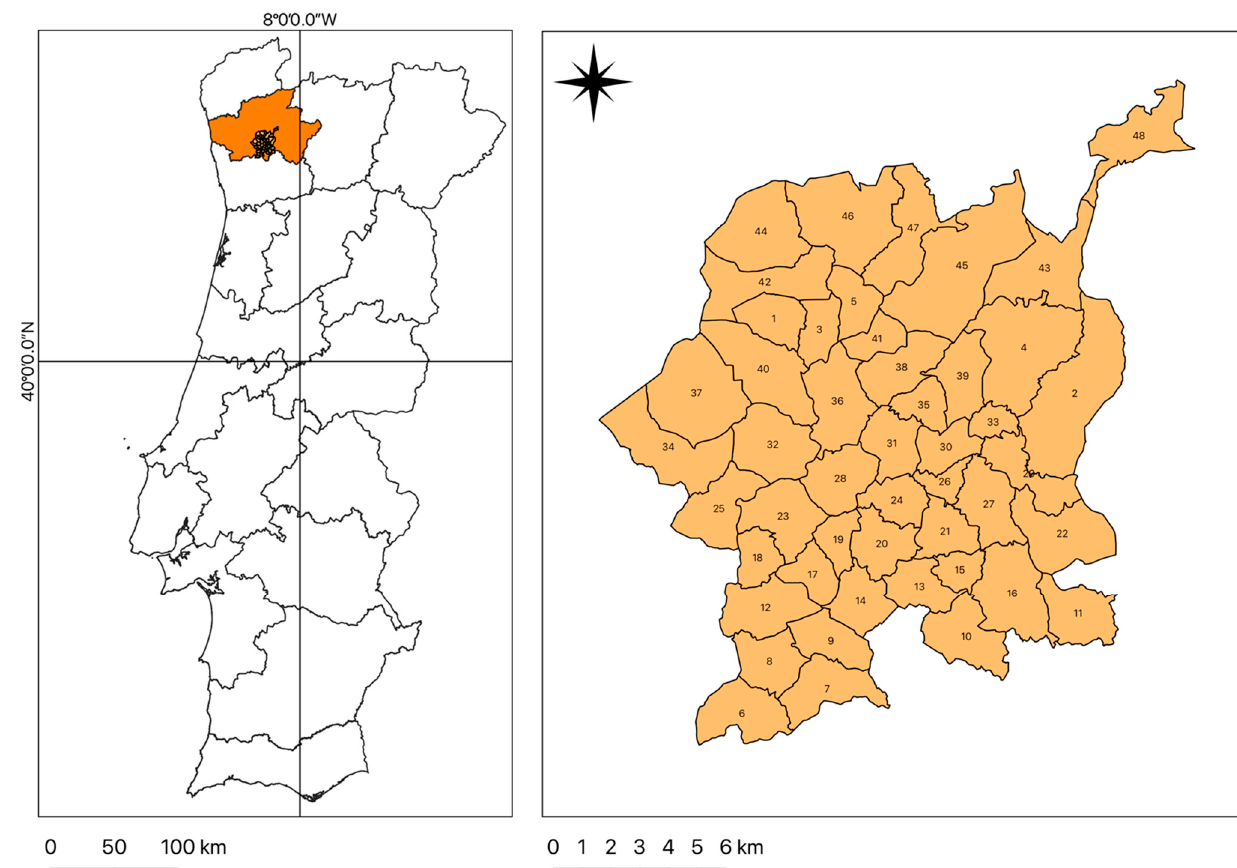
Figure 2. The municipality of Guimarães is located in Northern Portugal, in the district of Braga, also known as the Baixo Minho region. Guimarães is divided into 48 parishes, presented in the right side of the figure as follow: 1—Sande (São